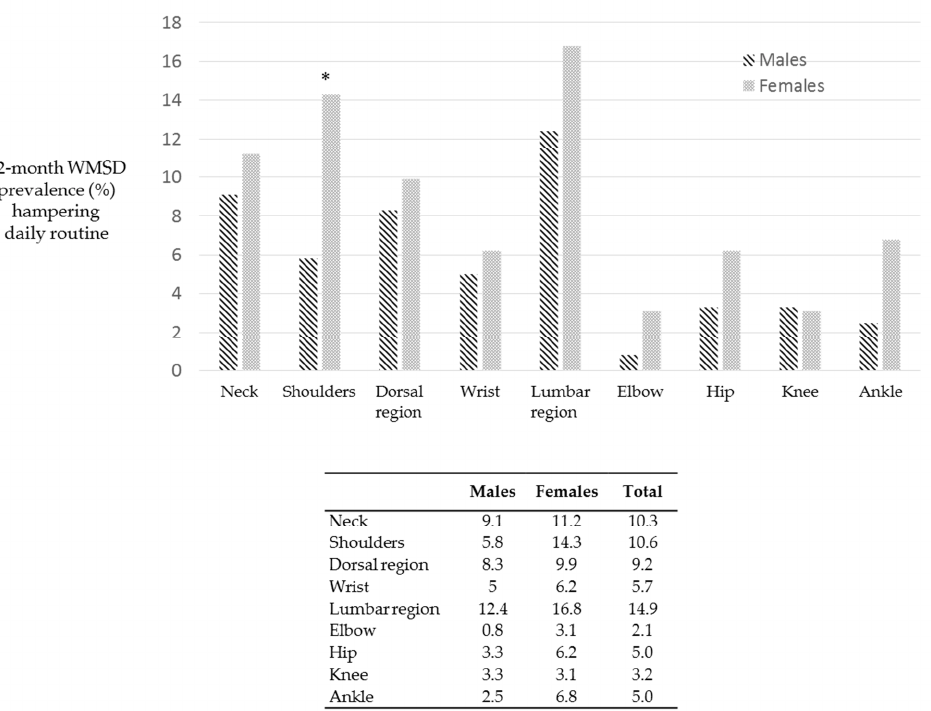
Figure 9. WMSD that impeded to perform normal activities in the last 12 months. Females reported higher percentages of WMSD in 8 / 9 body areas. Asterisk indicates statistically significant differences ( p < 0.05). Figure 10 reports the WMSD percentage in the last 7 days according to body region. Females showed higher WMSD percentages in all cases. The most affected areas were the Lumbar region (23.0%), neck (22.6%), shoulders (18.4%) and dorsal region. Females showed statistically higher percentages ( p = 0.024) in shoulder region compared to males, the values were 23.7% and 11.6% respectively. Similarly, dorsal region demonstrated statistically higher percentages ( p = 0.038) when compared to males, the values were 14.9% and 5.8%.